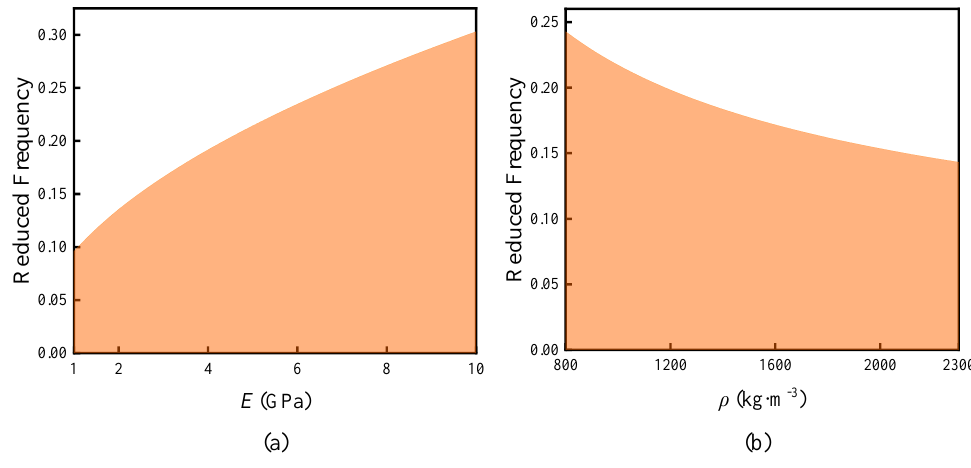
Figure 10. Effect of the material parameters on the band gap